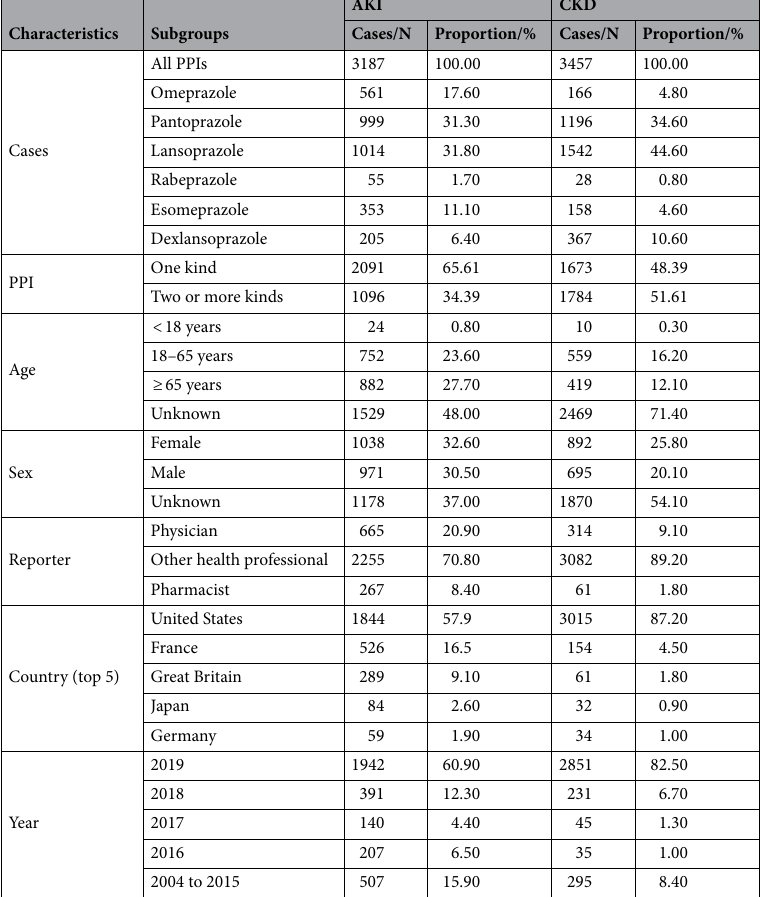
Table 1. Characteristics of PPIs associated AKI and CKD cases from FAERS database. PPIs proton pump inhibitors, AKI acute kidney injury, CKD chronic kidney disease.